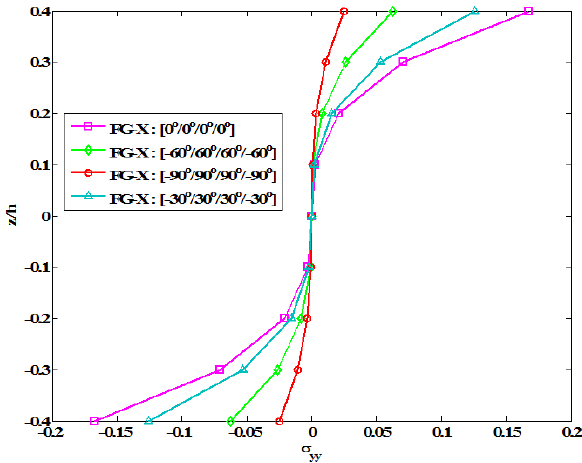
Figure 13: The non-dimensional stress σ yy for angle–ply [- θ / θ / θ /- θ ] FG-X SWCNT-FG plate with different lamination scheme